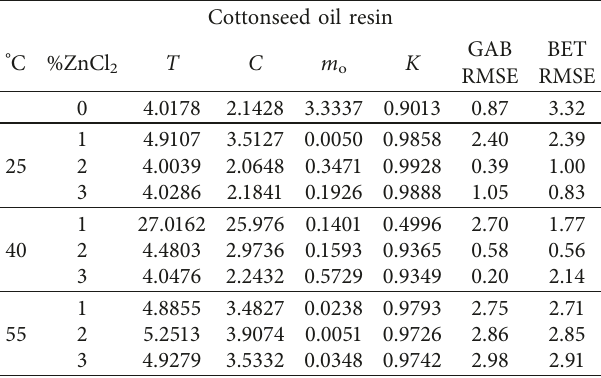
Table 2: GAB and BETparameters for moisture sorption isotherms for millet flour/epoxidized sesame and cottonseed oil resins ( m o g/ 100g water dry basis).